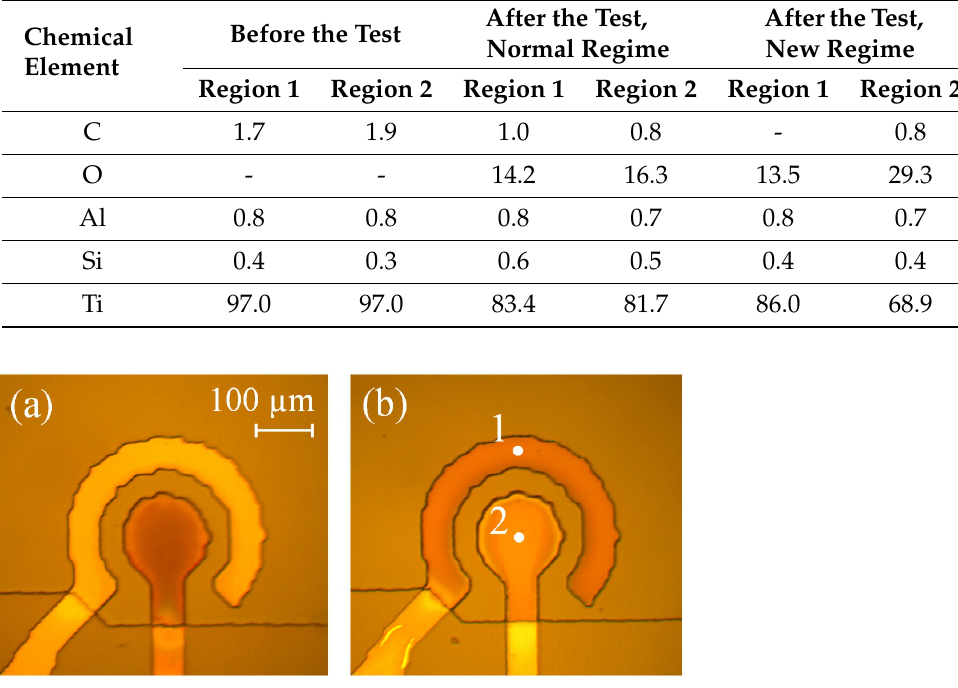
Table 1. Chemical composition of the concentric electrodes before and after the test in the normal and new regimes. EDX analysis is performed at the regions marked by the white points in Figure 8b. The content of chemical elements is given in atomic percent.